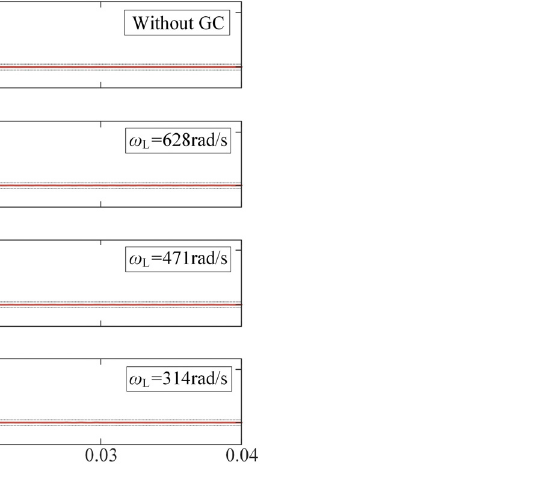
Figure 10. Convergence curves of SHEA error with GC under unit steps with different zero-related parameters ω L .